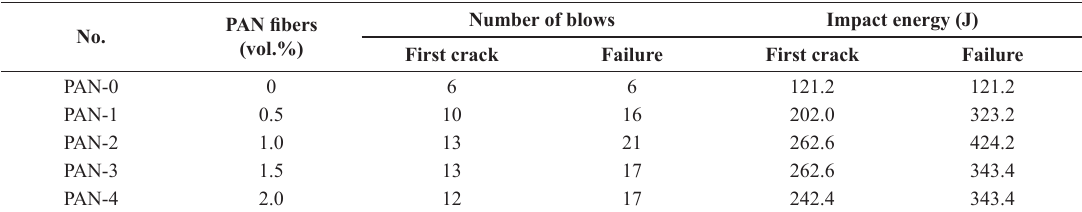
Table 4. Impact toughness performance of PAN fiber reinforced concrete.